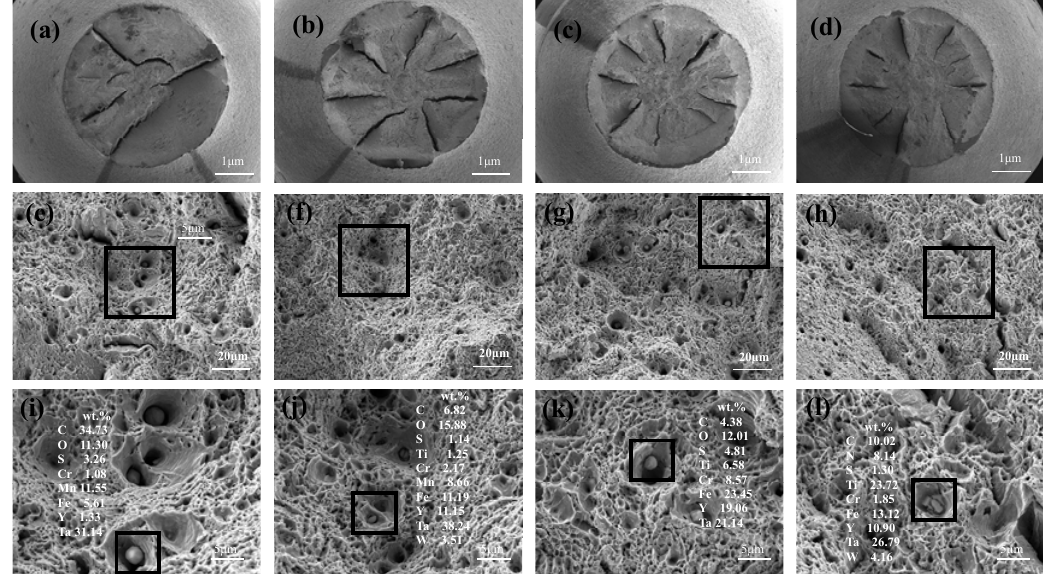
Figure10. Macro-andmicro-viewsofthefracturesurfaces: ( a , e , i )C1; ( b , f , j )C2; ( c , g , k )C3; and( d , h , l Figure 10. Macro- and micro-views of the fracture surfaces: ( a , e , i ) C1; ( b , f , j ) C2; ( c , g , k ) C3; and ( d , h , l ) C4.